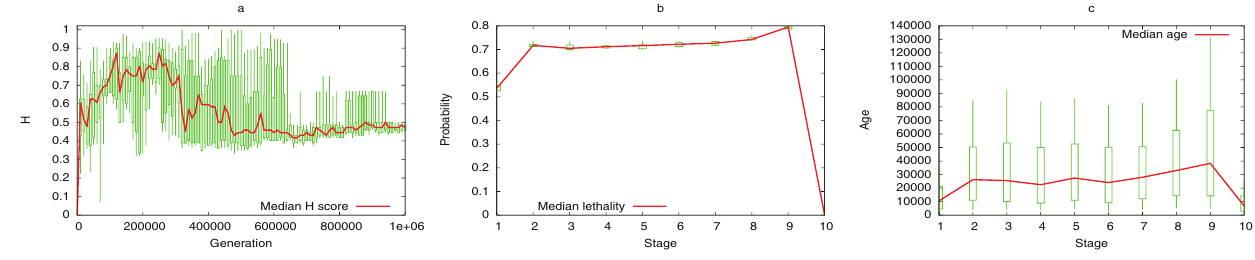
Figure 5. Computational results with Model-1. Parameters: 10 runs with different initial populations, N = 10 individuals, L = 10 stages, specificity function s ( l ) = 0.5 for all stages, Γ = 100 genes at each stage initially, RF parameter z = 4, 1,000,000 generations, probability of RW event P = 10 −4 . The red line is the median and the green boxes are the 10th, 25th, 75th, and 90th percentiles, across all individuals RW and all runs. ( a ) The hourglass score H across evolutionary time. ( b ) Lethality probability at each stage. ( c ) Age of existing genes at the last generation.